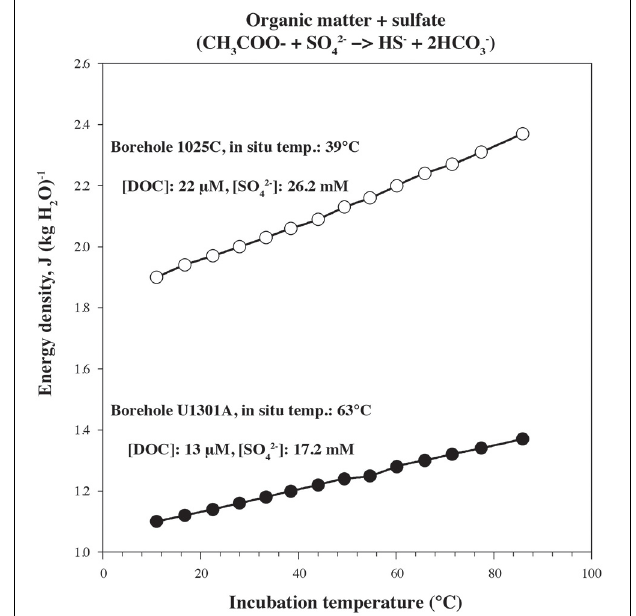
FIGURE 4 | Gibbs energy of reaction for organic matter being completely oxidized by sulfate in borehole 1025C (open circles) and U1301A (full circles) fluids as a function of temperature normalized per kg of H 2